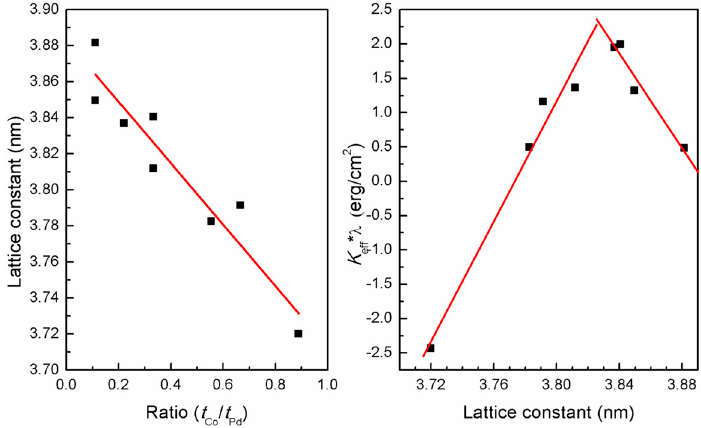
Figure 10. Plot of ( a ) lattice constant corresponding to the fcc (111) Co/Pd multilayers as a function of Co to Pd thickness ratio, and ( b ) effective anisotropy per bilayer ( t Co + t Pd ) of all the sample series as a function of the corresponding lattice constants.